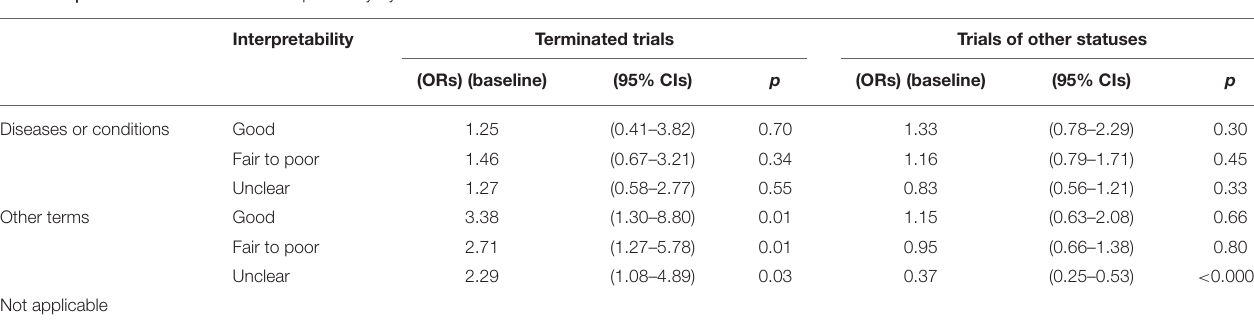
TABLE 2 | The odds ratios of index interpretability by trial